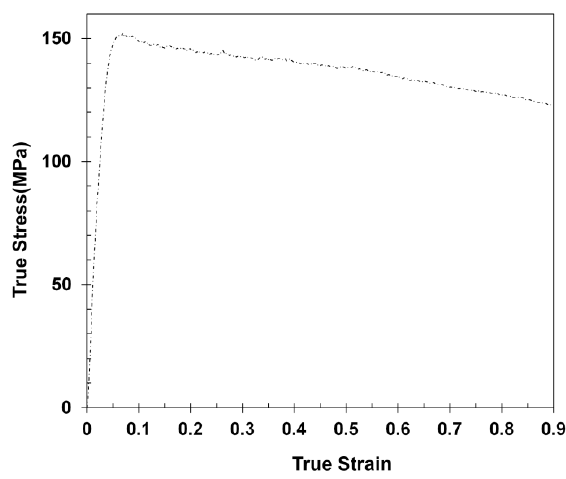
Figure 2. Stress-strain curve for Ti-10-3- 3 alloy deformed at 725 °C.